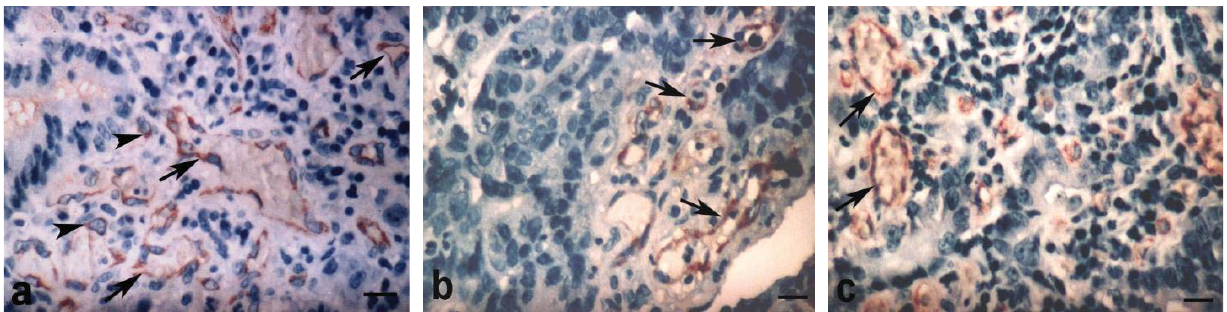
Figure 1. Representative FVIII immunostaining in blood vessels (arrows) and sprouts (arrowheads) in the center of the tumor (a), periphery (b) and metastasis (c) regions from GITC. Blood vessels with variable diameters and infiltration of tumor cells into lumen were also observed in the periphery region. Bar = 25 (cid:3) m.